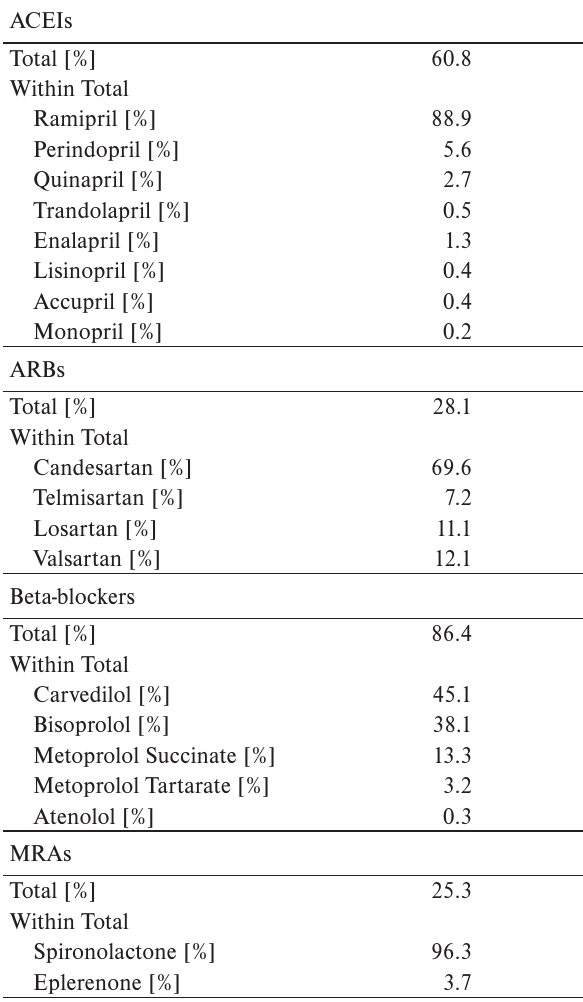
Table 2. Analysis of HF medical therapy at the time of the latest data